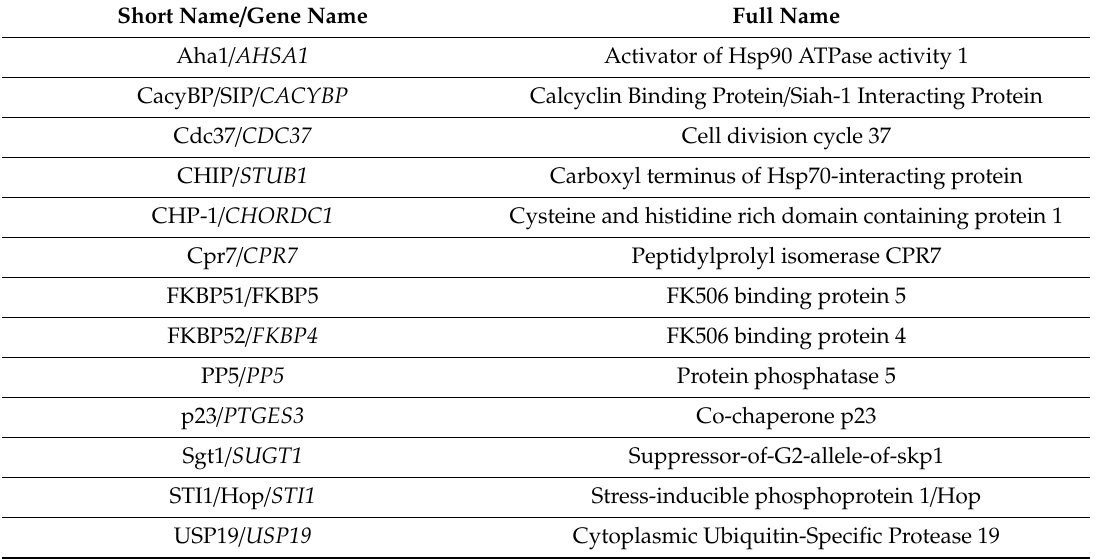
Table 1. Selected Hsp90